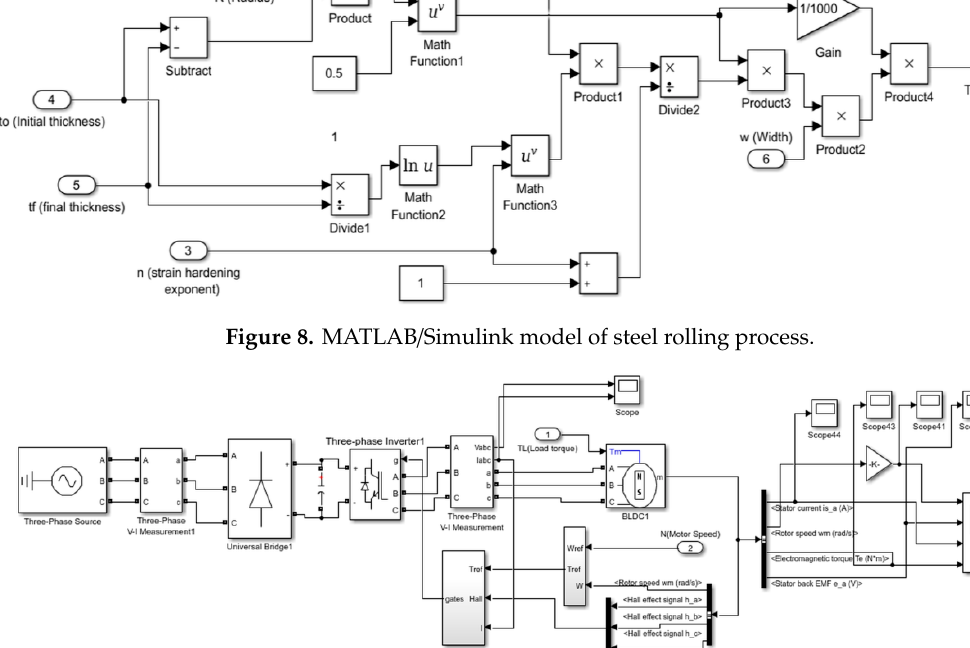
Figure 9. MATLAB/Simulink model in closed-loop operation of BLDC motor.